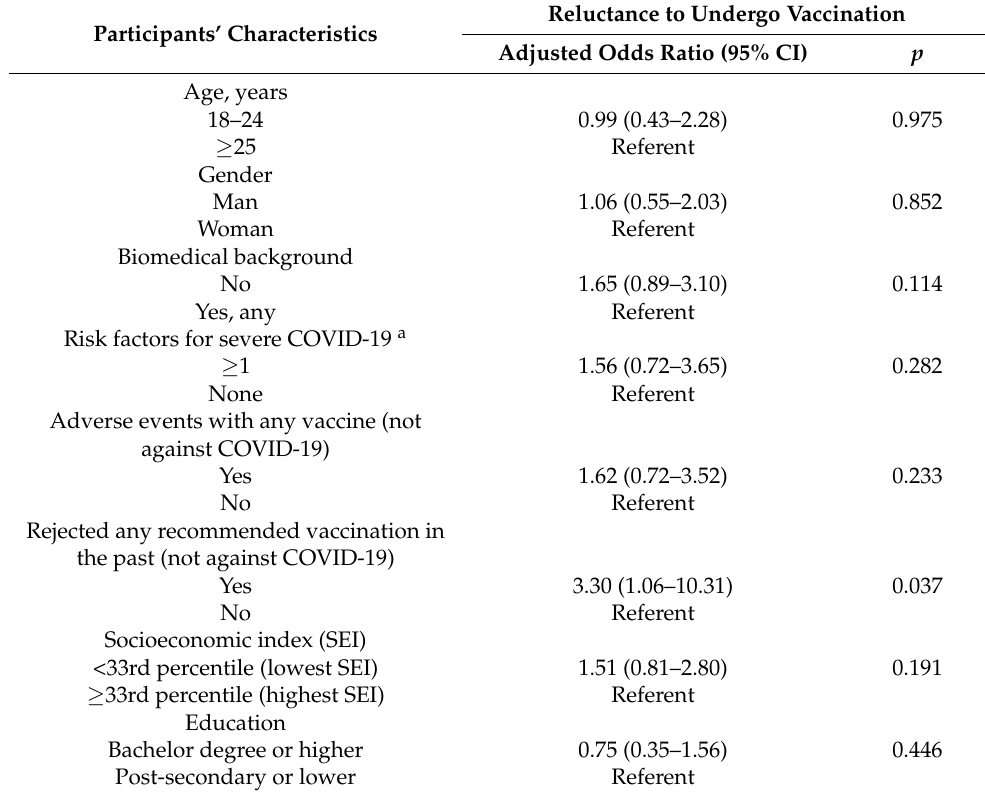
a Any set of the following: cancer, chronic liver disease; chronic obstructive pulmonary disease; cardiovas- cular diseases (e.g., heart failure, ischemic heart disease, cardiomyopathy); weakened immune system (e.g., after organ transplantation, human immunodeficiency virus, etc.); obesity; sickle cell disease; smoking; type 2 diabetes